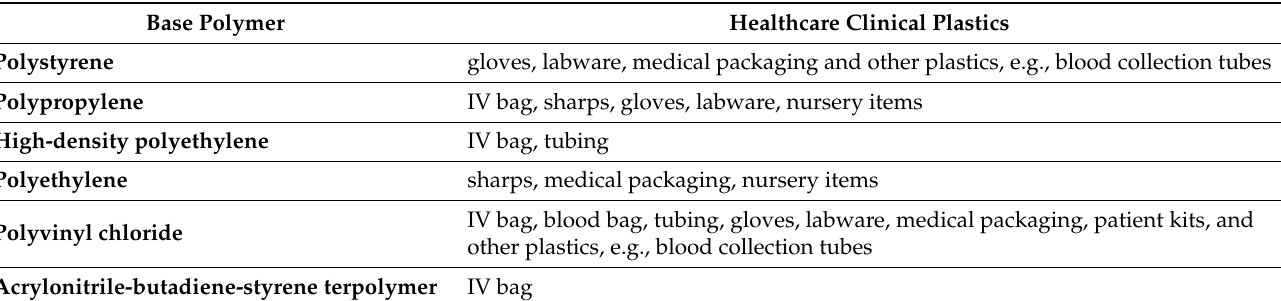
Table 2. Base polymers of some common medical plastic